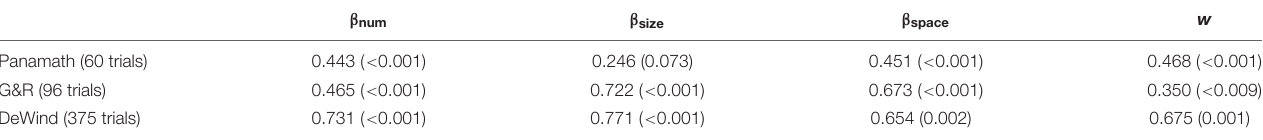
TABLE 3 | Test–retest